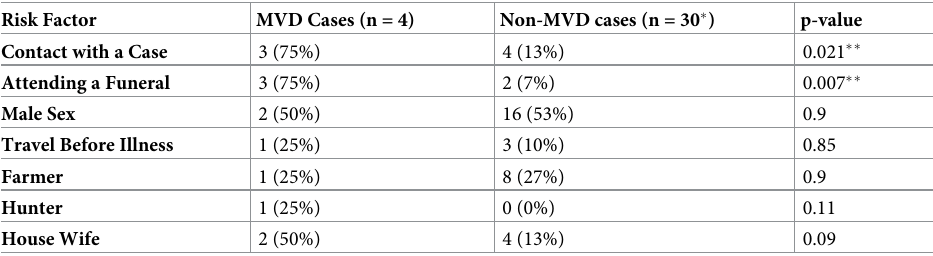
Table 2. Epidemiological risk factors for being MVD